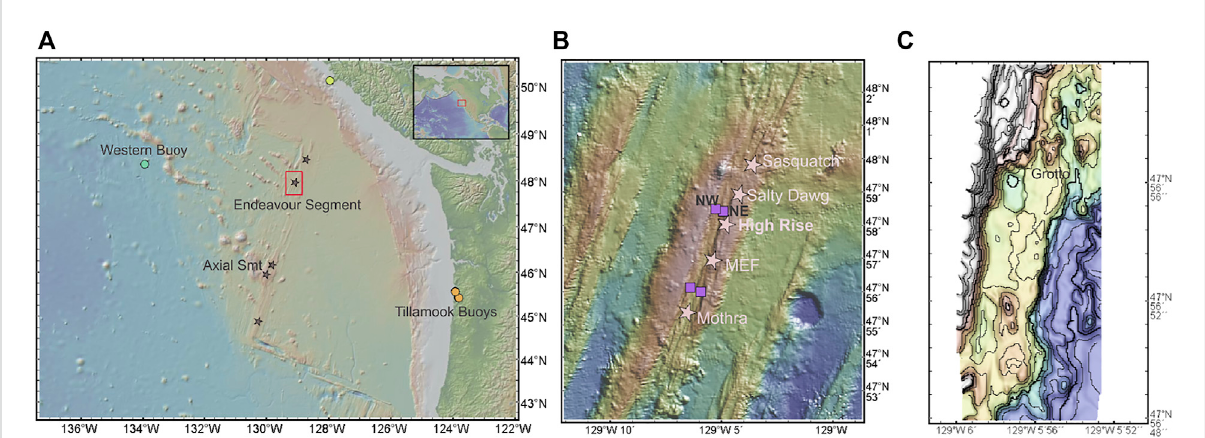
(Figure 1). Over that period, we observe long term time-dependent changes in the direction of hydrothermal discharge from the Grotto hydrothermal vent that are independent of broader oceanographic processes and suggest a systematic evolution in vent